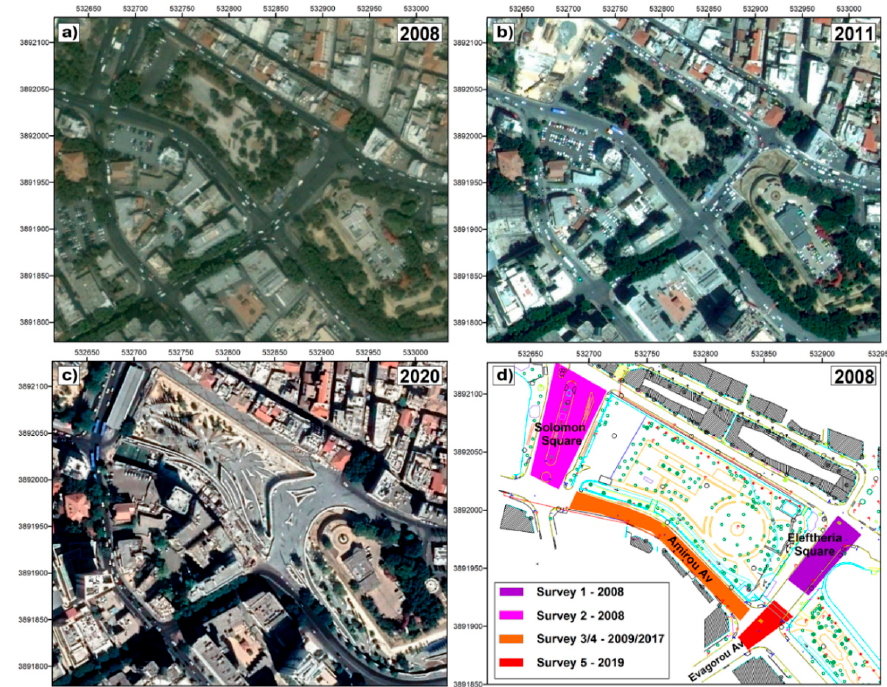
Figure 2. Google Earth ™ satellite images (2008, 2011, 2020) of Eleftheria Square and surrounding areas ( a – c ) and location of geophysical surveys ( d ).